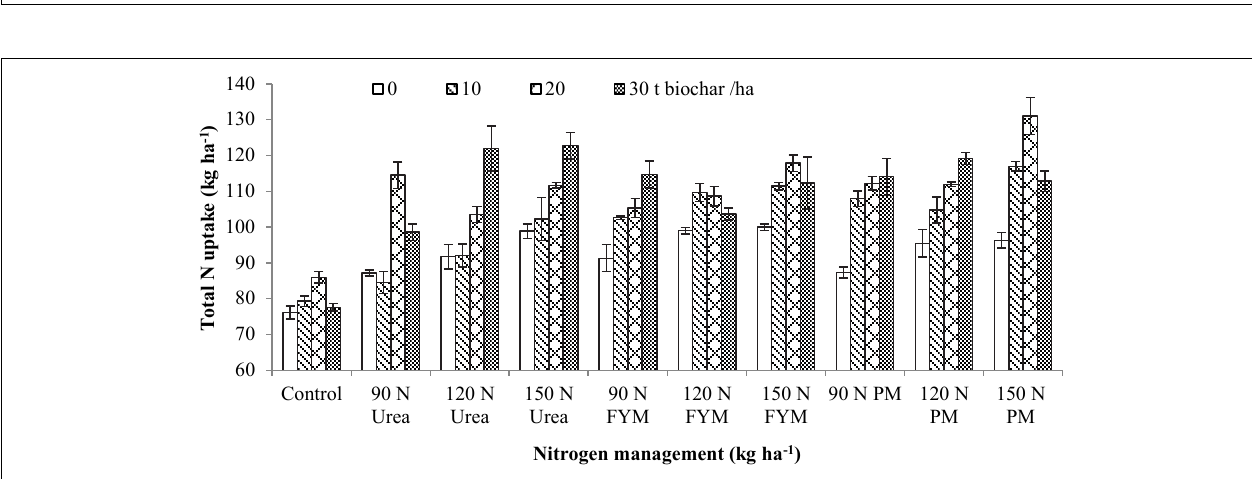
Frontiers in Plant Science |